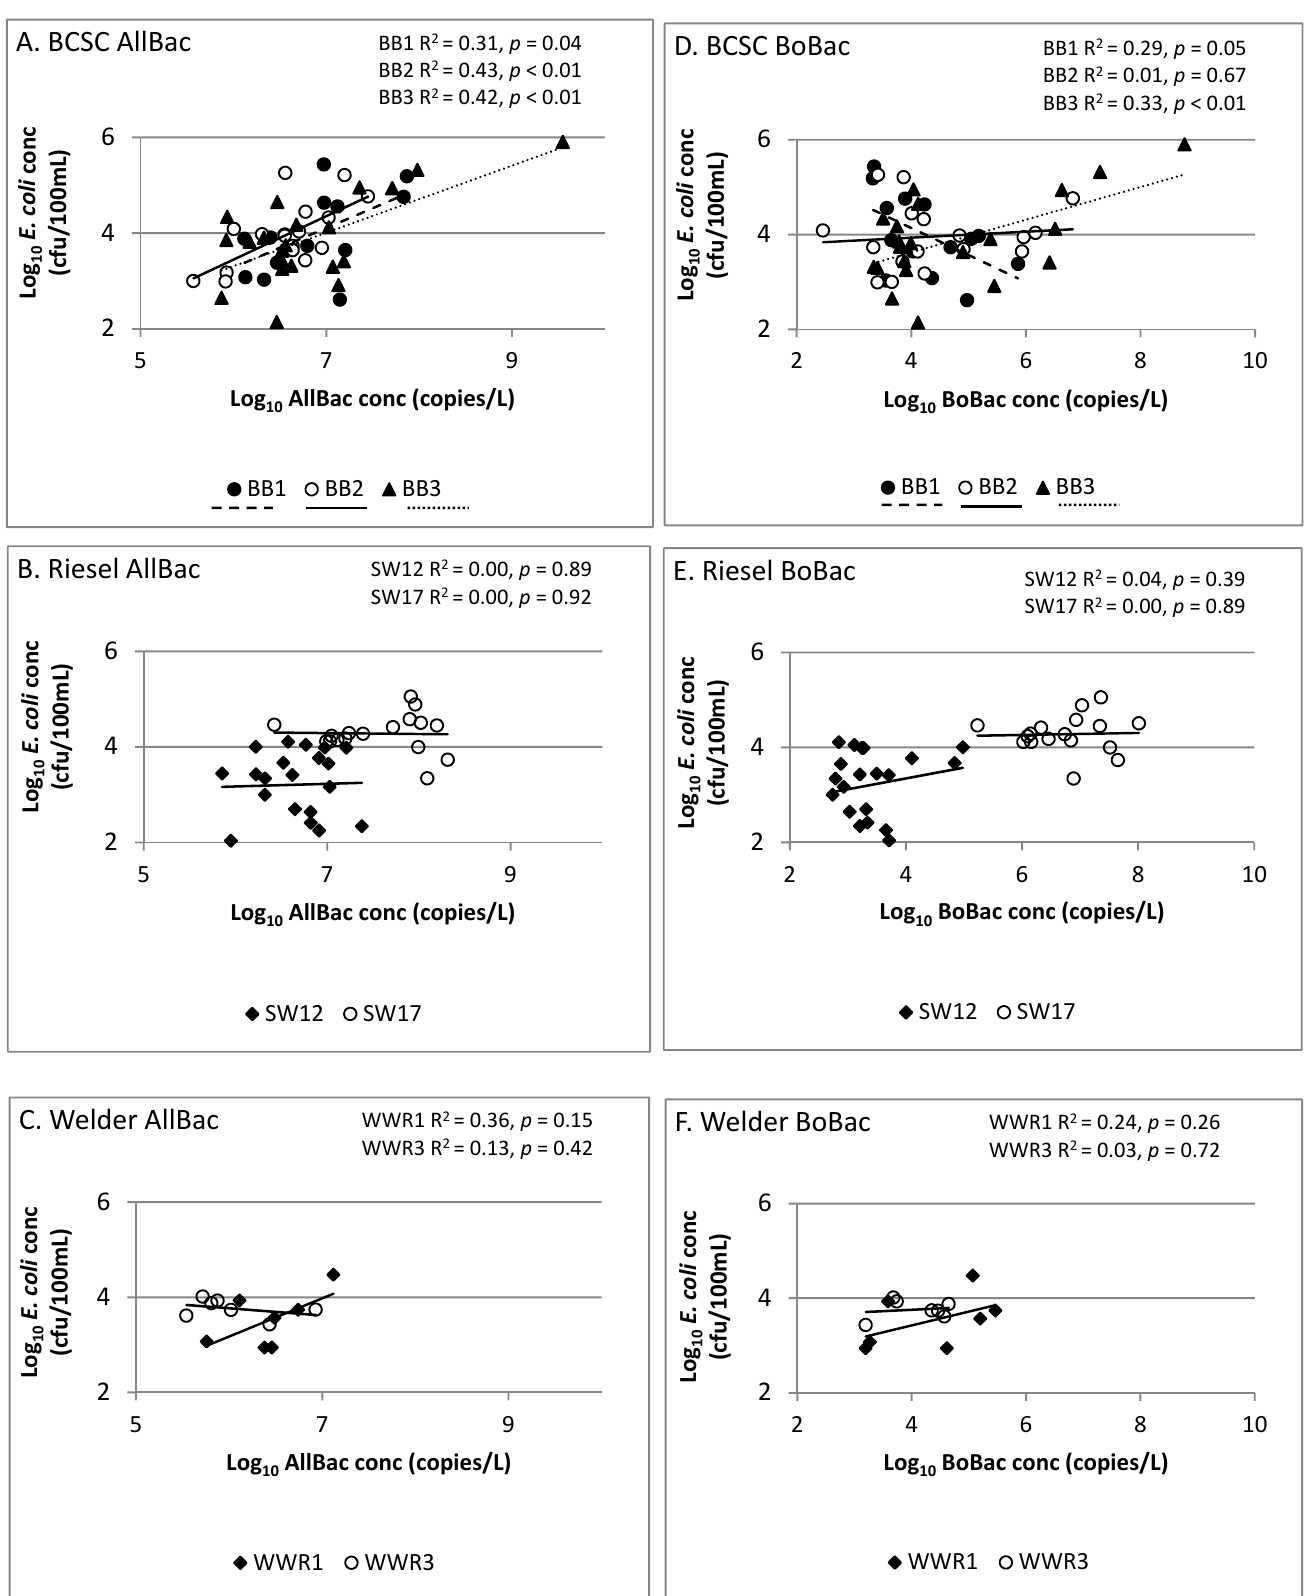
Figure 3. Linear regression analysis showing correlation of AllBac ( A – C ) and BoBac ( D – F ) levels to E. coli levels in runoff from grazing lands.